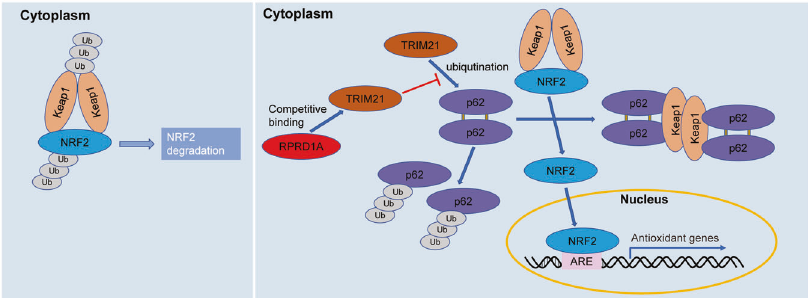
Fig. 7 A proposed model illustrating the mechanism of RPRD1A stabilizes NRF2. Under normal conditions, Keap1 interacts with NRF2 and ubiquitinates it to degrade via the ubiquitin-proteasome pathway. In response to oxidative stress, RPRD1A competes with p62 to bind TRIM21 and inhibits ubiquitination of p62 by TRIM21. The process releases p62 and causes its self-oligomerization, leading to the segregation and degradation of Keap1, which frees and stabilizes NRF2. Then, NRF2 translocates to the nucleus where it binds the antioxidant response element (ARE) and activates the transcription of antioxidant